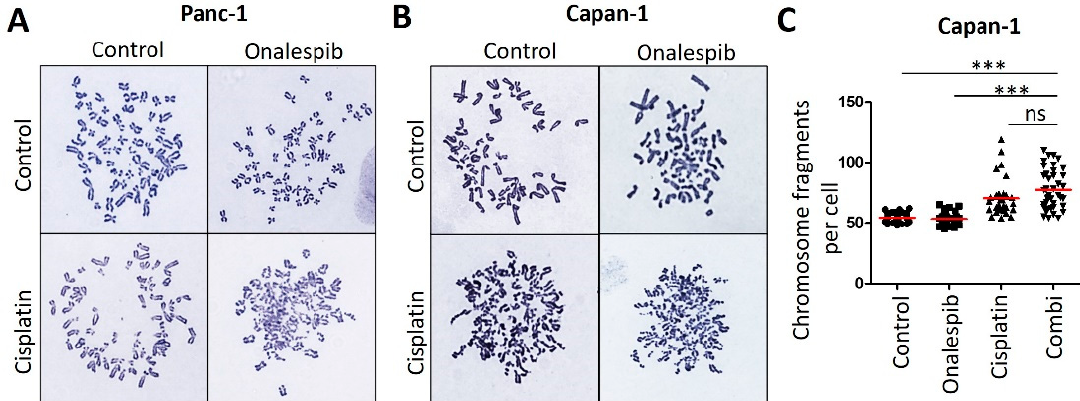
Figure A4. Cisplatin-sensitive PDAC cells revealed no significantly increased chromosome fragmentation upon HSP90 inhibition. ( A ) Representative images of metaphase spreads from Panc-1 cells, as in Figure 4E. Cells were treated with onalespib (100 nM) and cisplatin (20 µ M) for 24 h, together with 20 µ M zVAD to block apoptosis. Chromosomes were stained according to Giemsa. ( B ) Representative images of metaphase spreads. Capan-1 cells were treated as in ( A ). ( C ) Chromosome fragmentation was analyzed by counting the number of fragments shown in ( B ) in 40 randomly chosen cells from three independent experiments. The red lines indicate the mean. p values were calculated with one-way ANOVA comparing the indicated groups. ns = not significant, *** p ≤ 0.001.